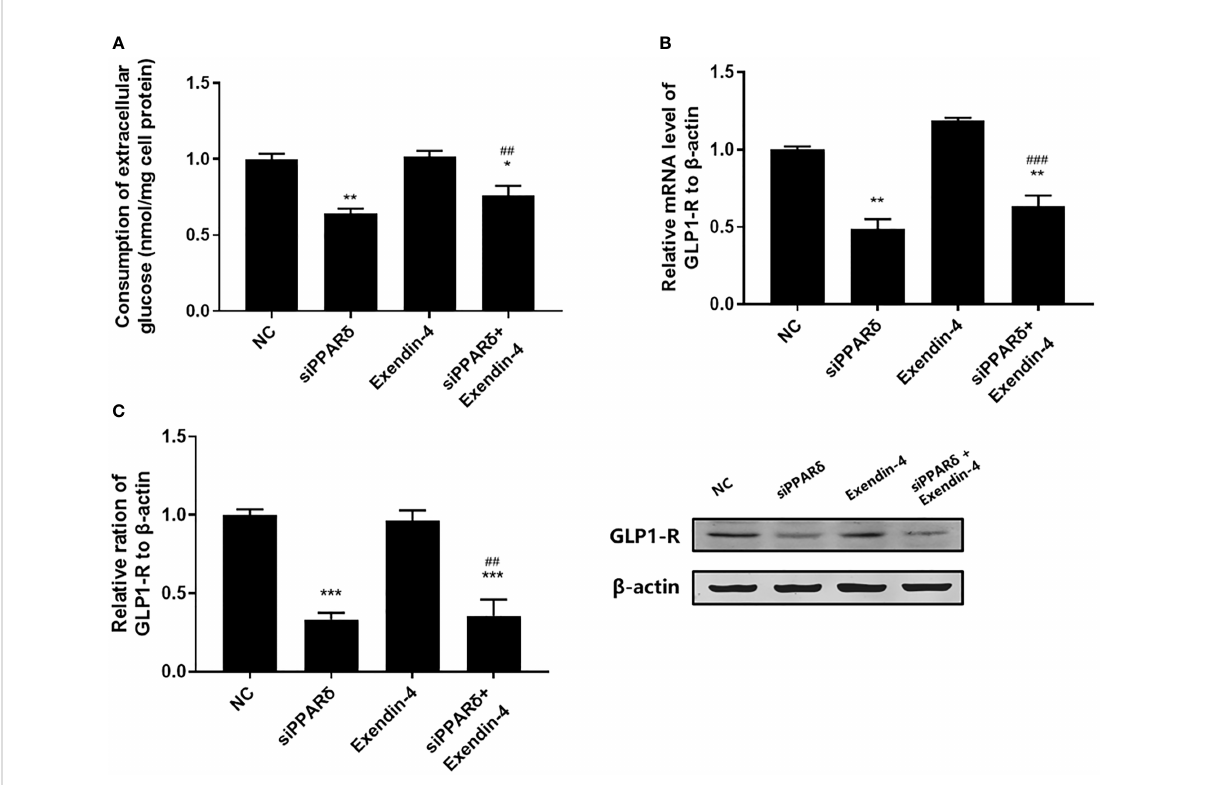
FIGURE 4 Effect of PPAR d knockdown on the exenatide therapeutic ef fi cacy by regulating the expression of GLP-1R. (A) Enzymatic methods were used to assay for glucose. (B) The mRNA level of GLP-1R was measured by RT-PCR. (C) The relative protein expression level of GLP-1R was measured by Western blot. Data are expressed as the mean ± SE, n = 3. * P < 0.05, ** P < 0.01 and *** P < 0.001 compared with NC. ## P < 0.01, ### P < 0.001 compared with